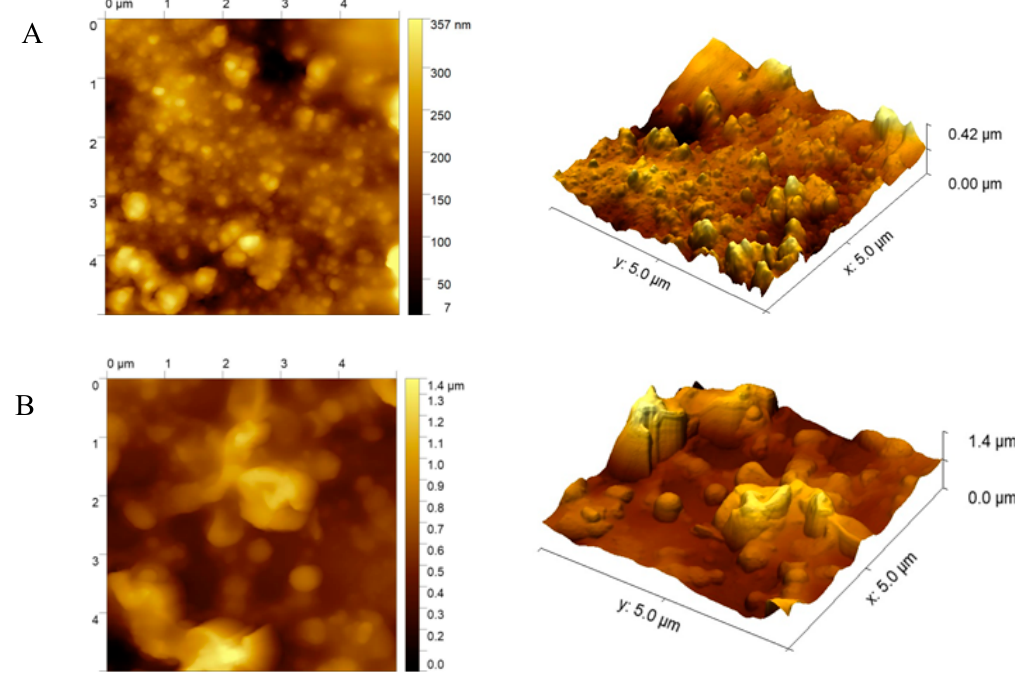
Figure 5. Representative AFM topography maps and surface 3D views of electrode surfaces modified with 2,6-bis(3,4-ethylenedioxythiophene)-4-methyl-4-octyl-dithienosilole ( A ) and 2,6-bis(selenophen-2-yl)-4-methyl-4-octyl-dithienosilole ( B ). Size: 5 × 5 µ